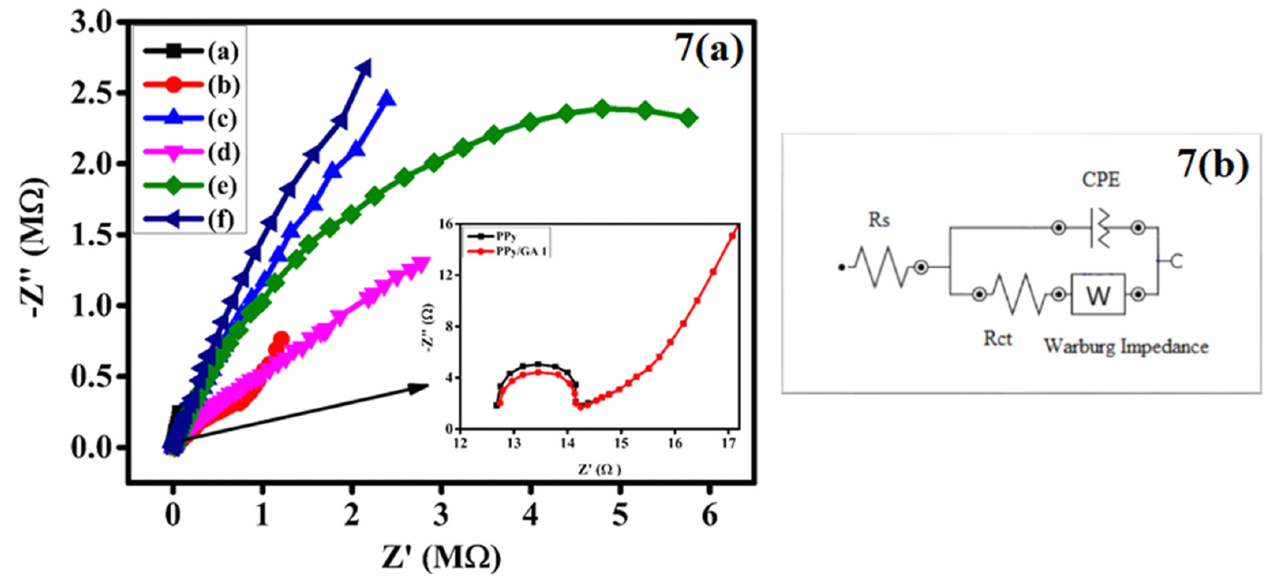
Figure 7. ( a ) EIS spectra of (a) PPy, (b) PPy/GA 1, (c) PPy/GA 2, (d) PPy/GA 3, (e) PPy/GA 4, and (f) PPy/GA 5. ( b ) Equivalent circuit for EIS.